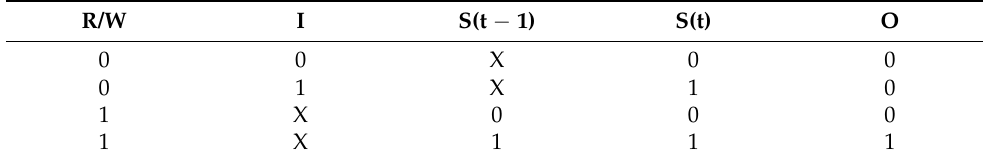
Table 1. Truth table of CAM cell memory unit.